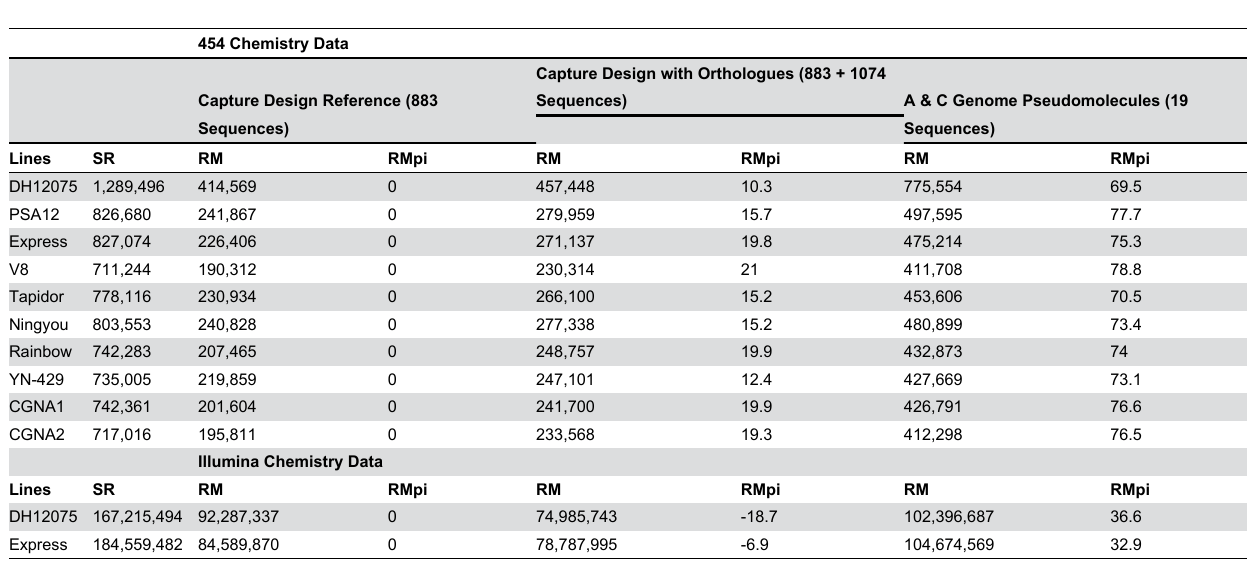
Table 4. Summary of sequence read mapping performance using multiple reference sequence